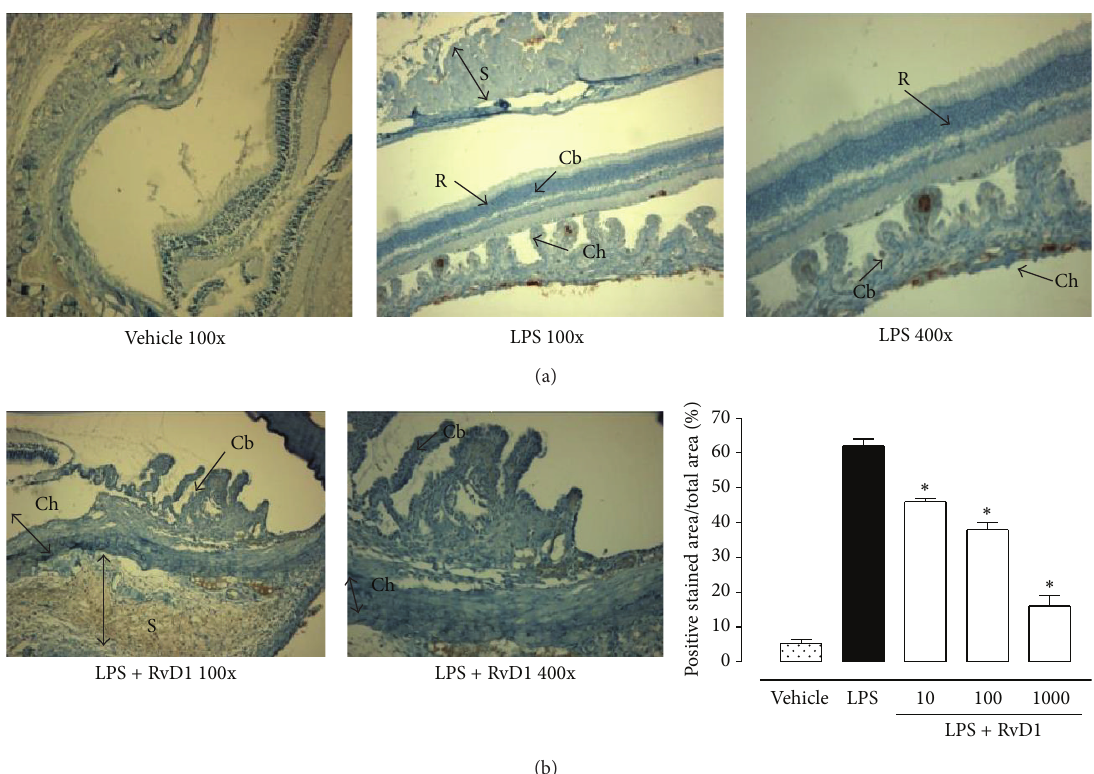
Figure 10: (a) Representative immunohistochemistry of eye tissues showing that treatment with resolvin D1 (RvD1, 10ng/kg 1h post-LPS) reduces immunostaining for anti-integrin alpha X/CD11c antibodies selective for M1 macrophages phenotype. (b) Graphs showing the percentage of positive stained area per total area analyzed at 400x magnification. Values are mean ± SEM of 𝑛 = 6 observations for group. ∗ 𝑃 < 0.05 and ∗∗ 𝑃 < 0.01 versus LPS-treated group. R = retina; S = sclera Cb = ciliary bodies; Ch = choroid.